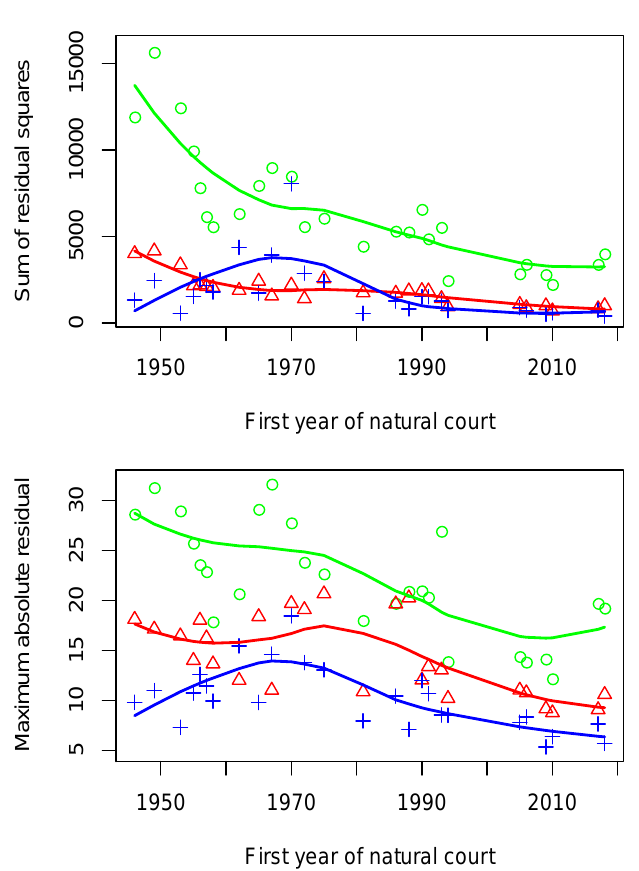
Figure 5. Sum of squares of residuals ( top ) and maximum absolute value of residuals ( bottom ) across all natural courts in the modern SCDB (plotted at the first year of each natural court), together with a smooth trend line provided by local polynomial regression, for one-dimensional MDS (green), two-dimensional MDS (red), and tree estimation